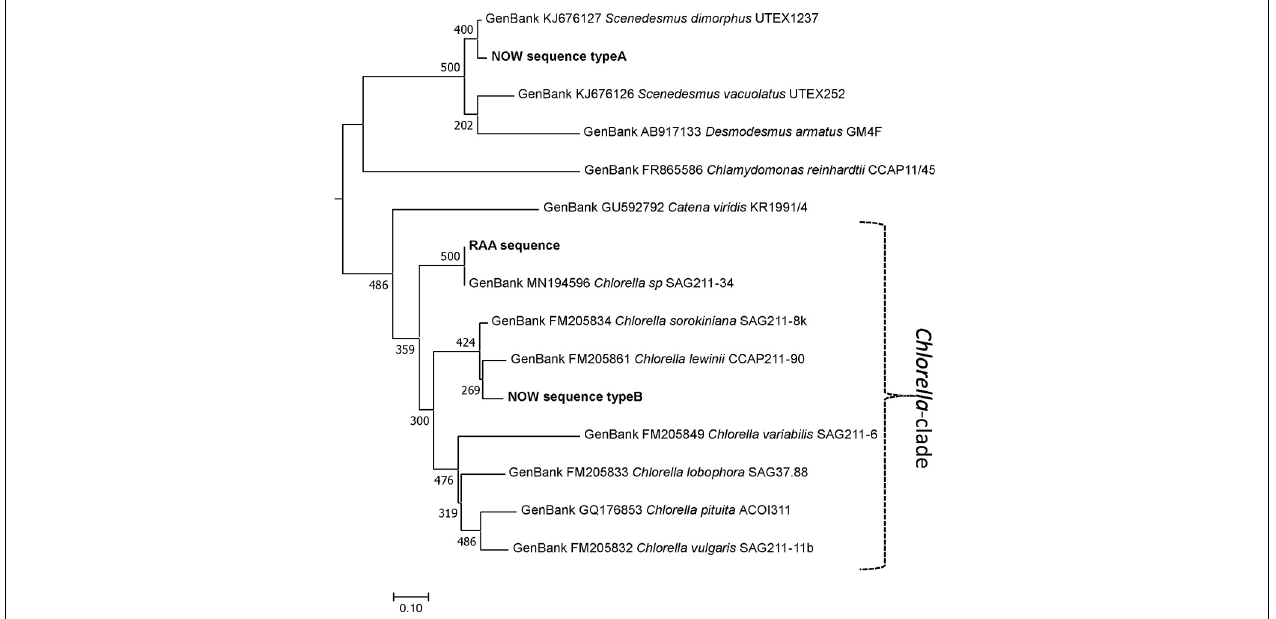
FIGURE 8 | Phylogeny of the ITS1-5.8S-ITS2 rDNA fragment of different microalga species. Experimentally obtained sequences (marked bold) were aligned with database entries; GenBank accession numbers are provided for each of these. Sequences were aligned using the MAFFT alignment tool with the algorithm L-INS-i (Katoh and Standley, 2013), and phylogeny was inferred using PhyML (Guindon et al., 2010). Branch support was calculated by 500 bootstrap repetitions. The tree was rooted on midpoint and visualized in MEGA7 (Kumar et al., 2016). Scale bar: base substitutions per